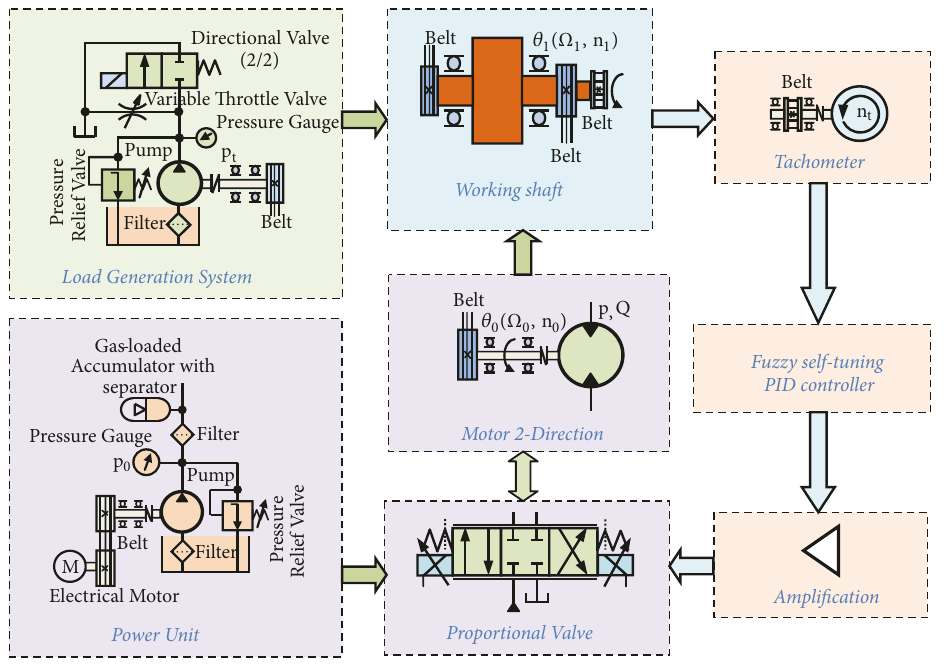
Figure 1: System configuration.